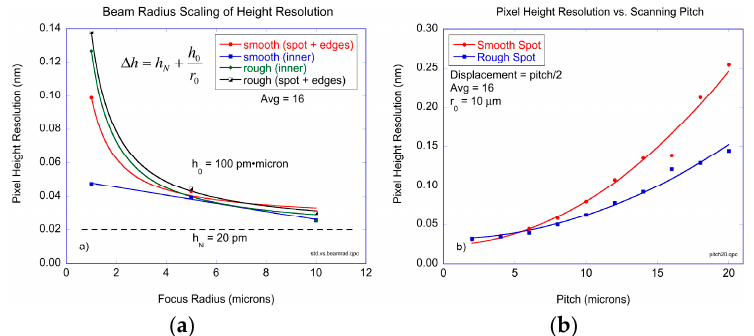
Figure 6. ( a ) 2D scan surface height resolution without dismount for the smooth and rough protein spots. ( b ) Pixel height noise as a function of the scan pitch for a fixed beam radius of 10 μ m.